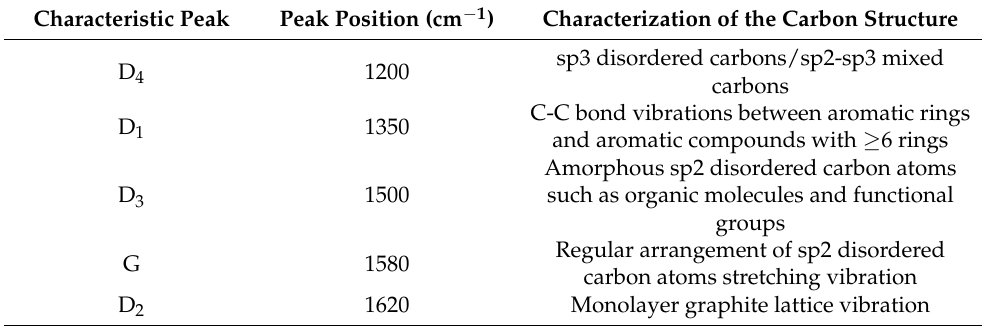
Table 6. Meaning of characteristic peaks of Raman spectrum.